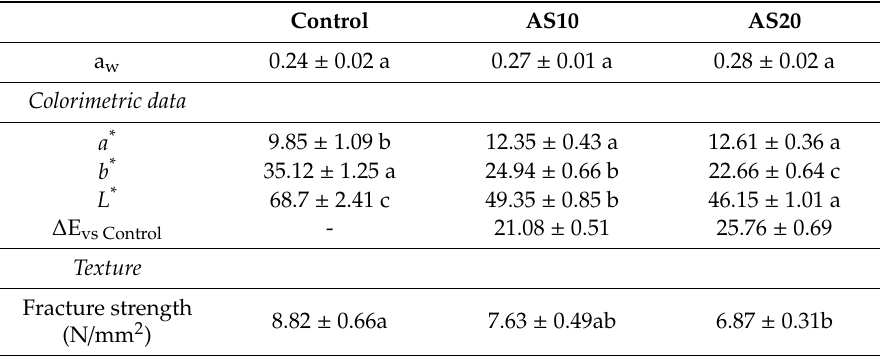
Table 5. Physical characteristics of biscuits enriched by increasing levels of almond skins. Control = biscuits without almond skins; AS10 and AS20 = biscuits prepared by adding 10 g and 20 g of almond skin powder per 100 g of wheat flour,